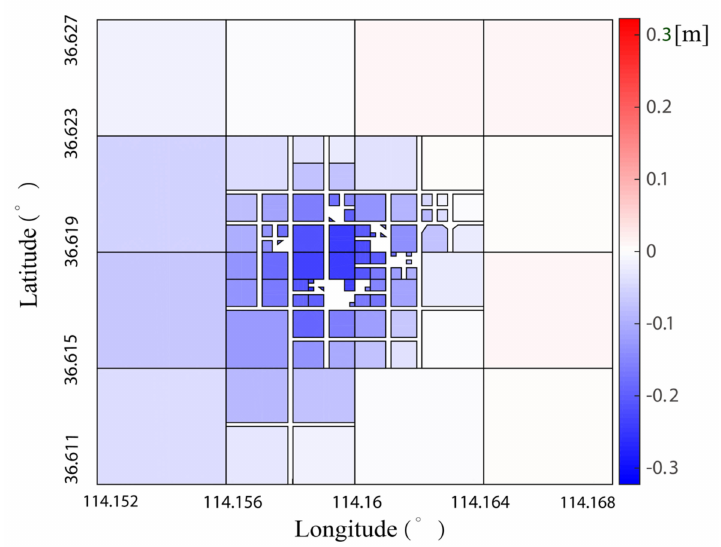
Figure 9. LOS deformation of the study area after subsampling. Table 3. Comparisons between the inverted and measured geometric parameters of the 132,610 working face.